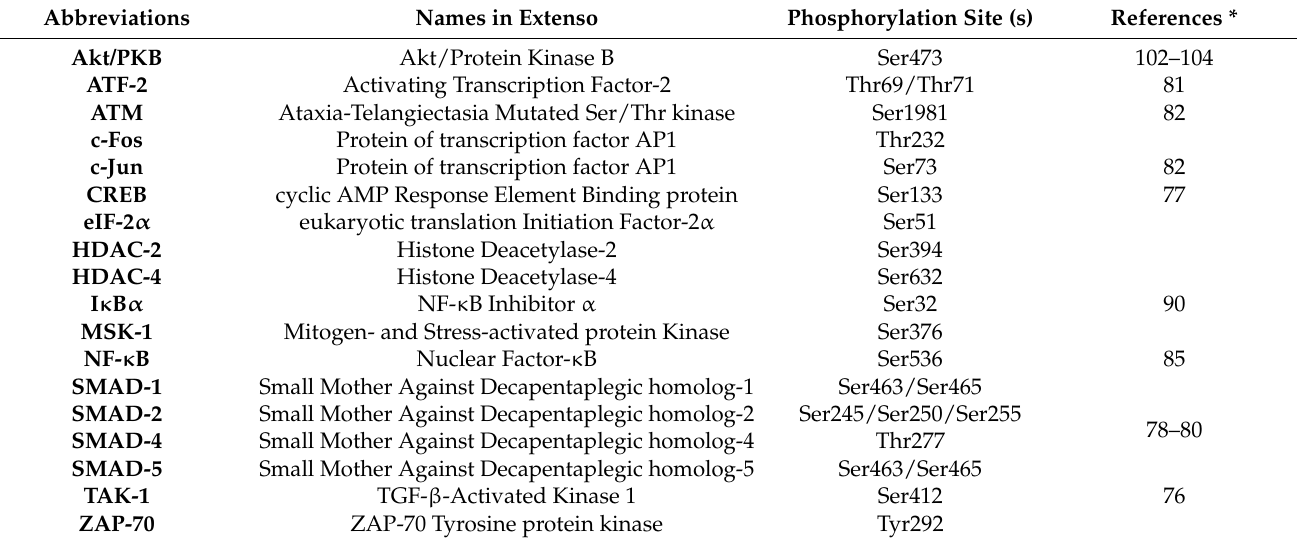
Table 1. Phosphorylated proteins investigated via membrane-based double antibody